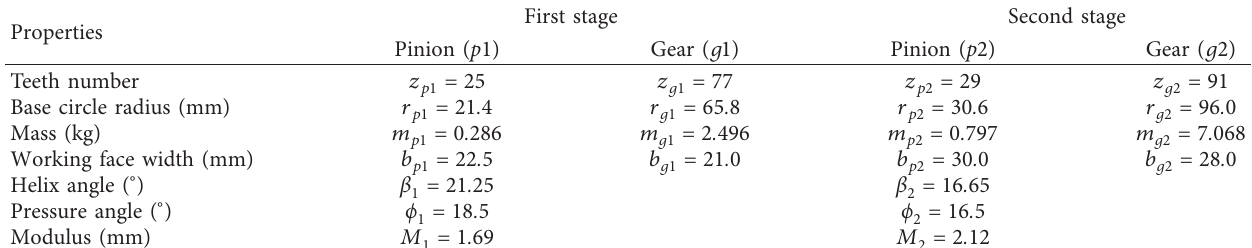
Figure 1: A simplified dynamic model of a TSHG system. Table 1: The geometric properties of the TSHG